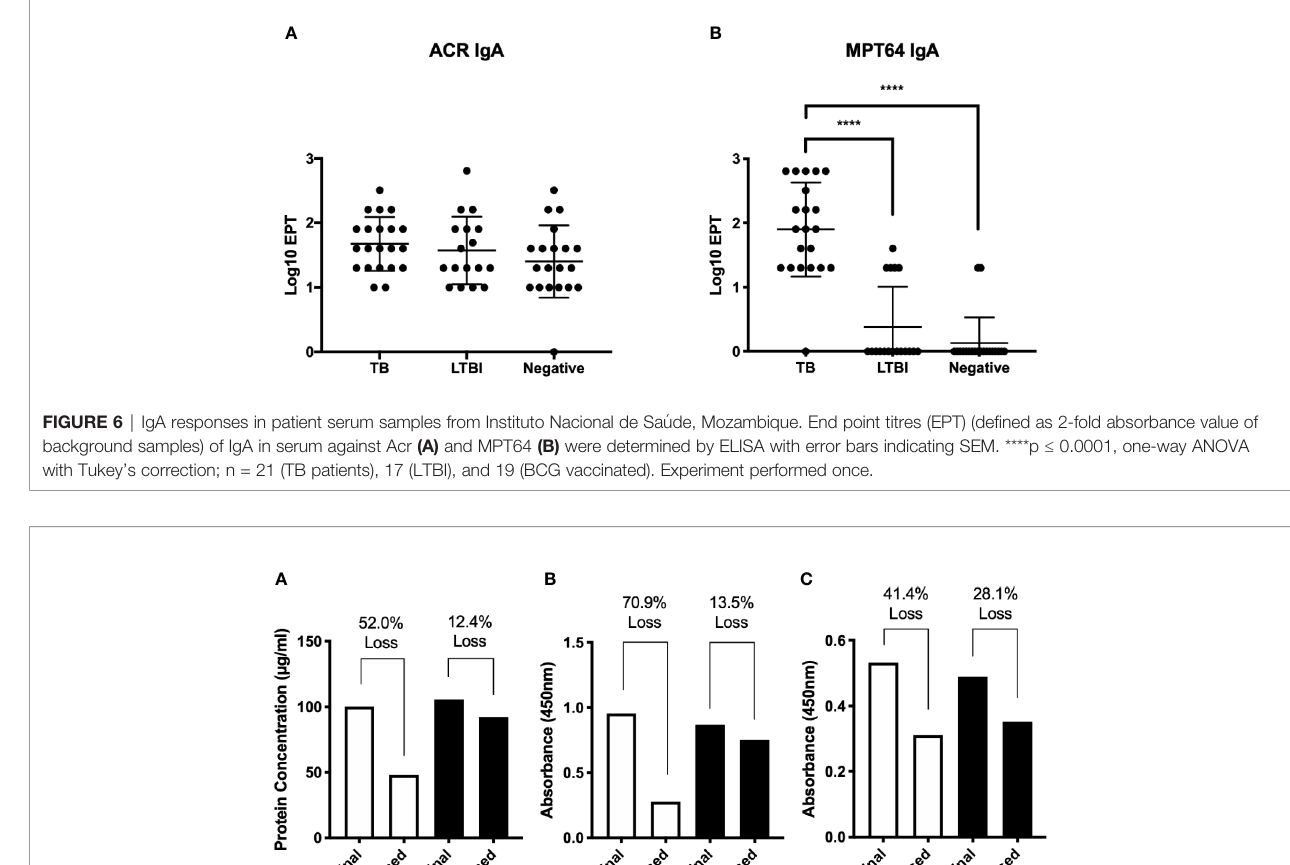
FIGURE 7 | Assessing the feasibility of aerosolized delivery of 2E9IgA1. 1 ml of 100 µg/ml of 2E9IgA1 was nebulized using an Omron MicroAir U22 portable mesh nebulizer, either in PBS alone or with 0.01% Tween-20. Condensate was collected, protein was recovered (A) , and Acr binding by ELISA (B) and recombinant CD89 binding activity by ELISA (C) were investigated to compare original and nebulized samples with equal protein loading. Experiment performed twice, with similar